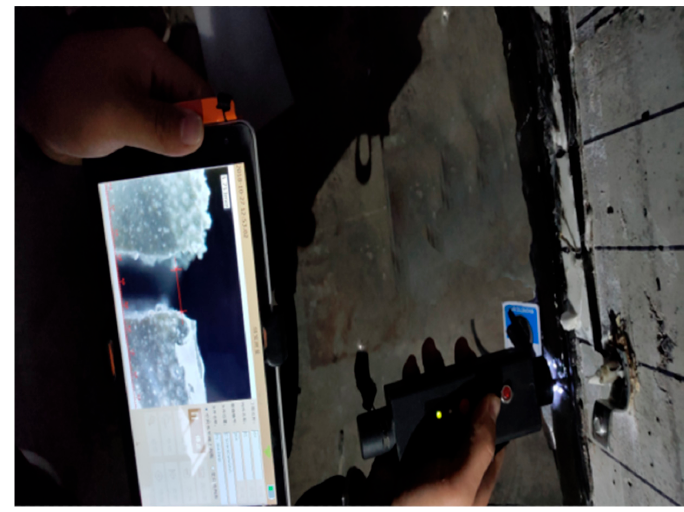
Figure 11. L3 crack penetration.